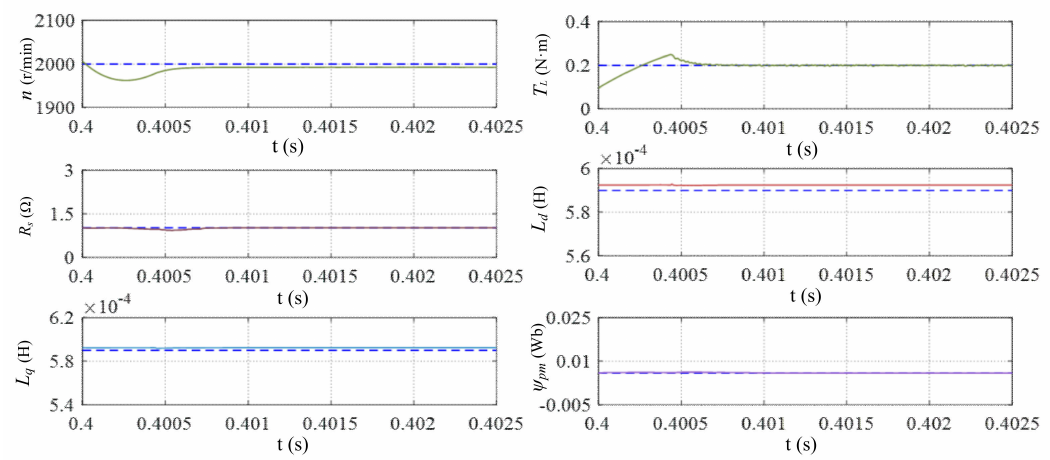
Figure 12. Parameter identification results when changes